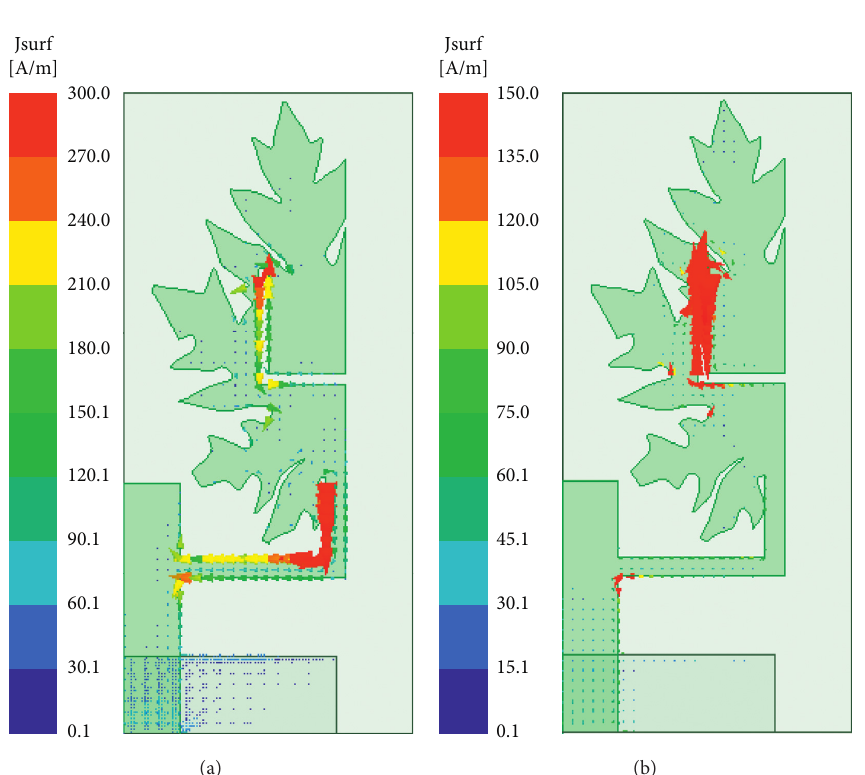
Figure 13: Distribution of surface current on Carica papaya BioAs-MPA antenna at (a) 2.4GHz (TM